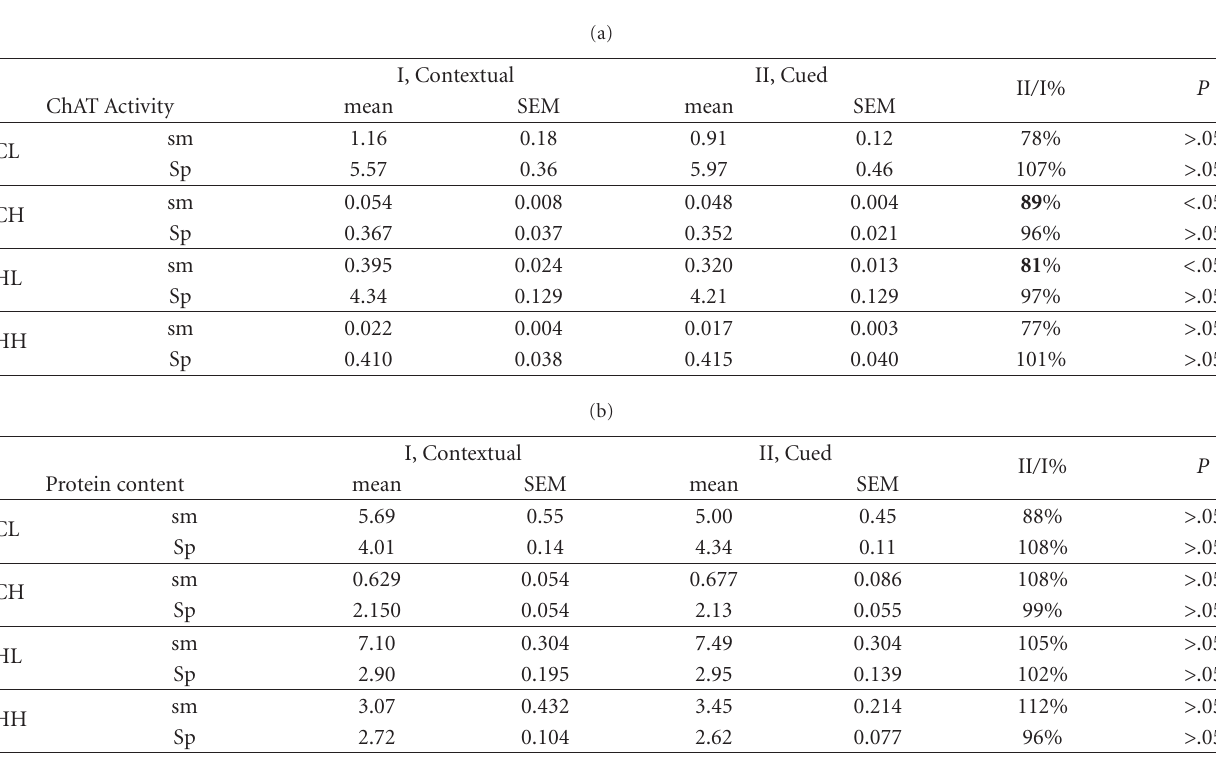
Table 1: ChAT activity and protein content in the subfractions of the synaptic membranes and the synaptoplasm of light and heavy synaptosomes of the cortex and the hippocampus in the spatial contextual (I, Contextual) and the spatial cued (II, Cued) biochemical subgroups of rats under the normal conditions. CL: the cortical light synaptosomes fraction; CH: the cortical heavy synaptosomes fraction; HL: the hippocampal light synaptosomes fraction; HH: the hippocampal heavy synaptosomes fraction; sm and Sp: the synaptic membranes and the synaptoplasm subfractions, respectively. The values of ChAT activity (nmoles acetylcholine/min) and protein content (mg) were expressed in 1g of wet weight of tissue. In the contextual/cued biochemical subgroups n = 5 / 4, respectively. P < . 05, significant di ff erences between the contextual and cued biochemical subgroups by the Fisher’s Exact